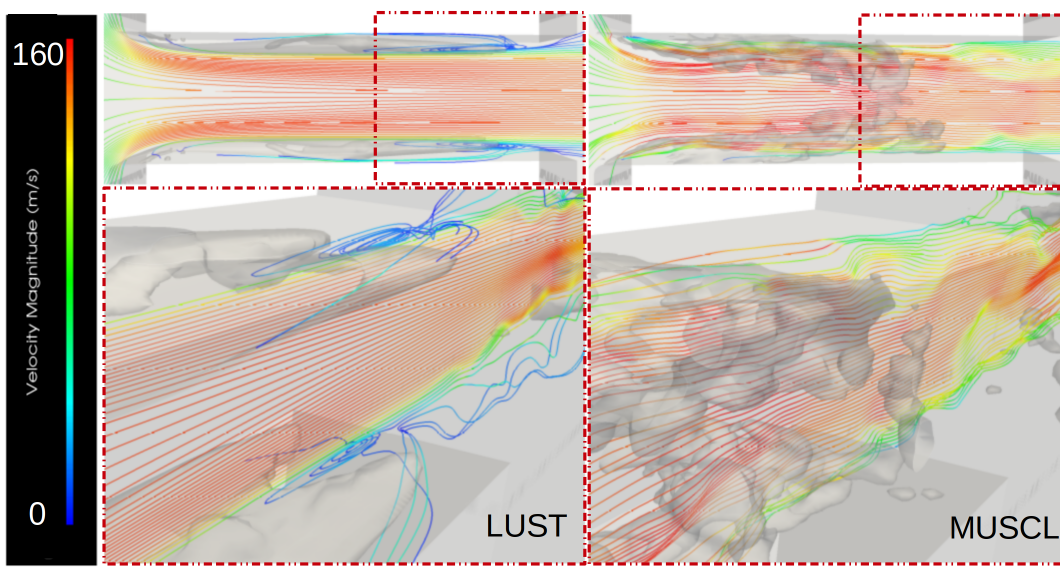
Figure 12. Streamlines within the centre of the nozzle with colour distribution displaying velocity magnitude with a superimposed contour at vapour fraction of